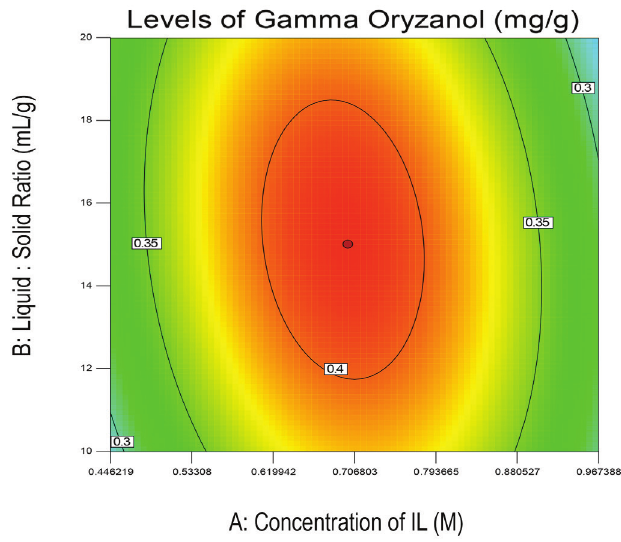
FIGURE 4 - Heat area coordinates.